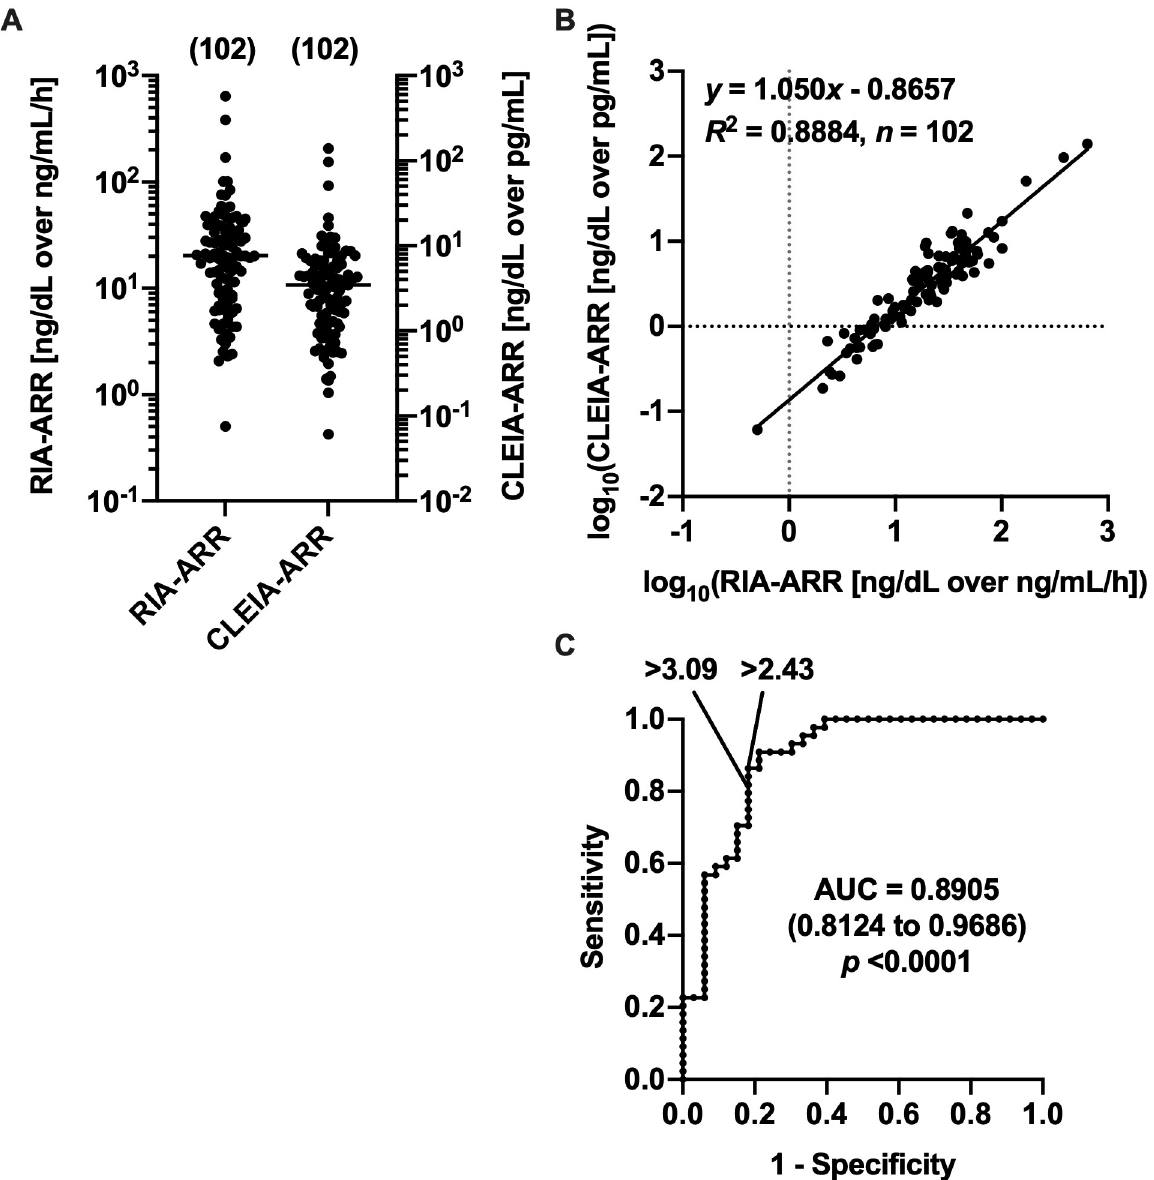
Fig 5. Analyses of RIA-ARR and CLEIA-ARR values. In the samples of Basal group and samples at 60 min after the loading of captopril challenge test (CCT60), the distributions of RIA-ARR and CLEIA-ARR values (A) and the linear regression analysis between their log- transformed values (B) are shown. In panel A, the numbers of samples analyzed are shown in parentheses and medians are indicated by horizontal bars. (C) The ROC analysis to determine the cutoff of basal CLEIA-ARR to detect PA patients. For the ROC analysis, only the samples of Basal group are used; numbers of non-PA and PA samples are 33 and 44, respectively. The area under the curve (AUC) of ROC curve is shown with the 95% CI in a parenthesis and p value. The cutoff maximizing the Youden index ( > 2.43 ng/dL over pg/mL) and that corresponding to RIA-ARR of 20 ng/dL over ng/mL/h ( > 3.09 ng/dL over pg/mL) are